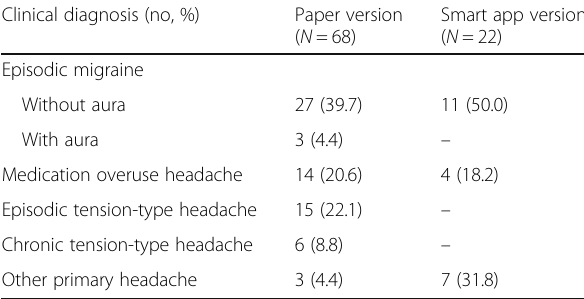
Table 5 Clinical diagnosis distribution of false positive patients Clinical diagnosis (no,